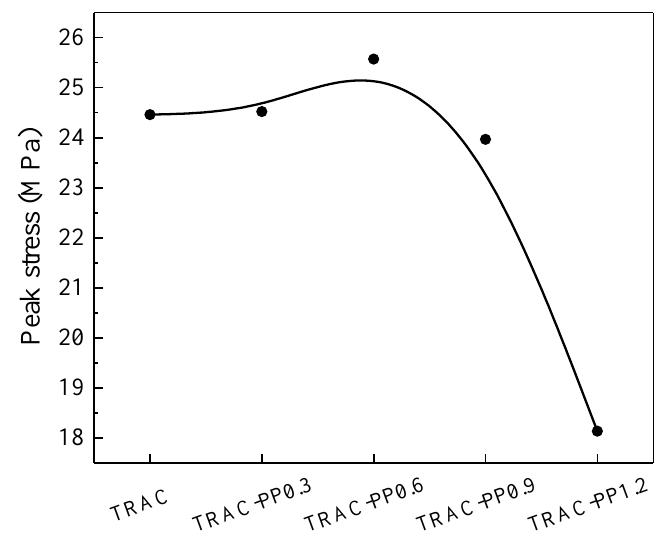
Figure 5. Effect of PPF content on the peak stress of TRAC-PP.